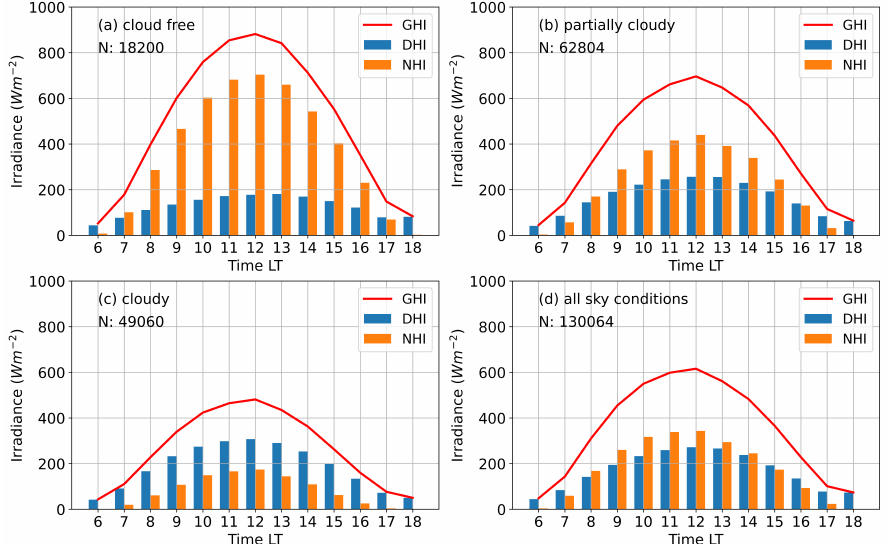
Figure 3. Averages of hourly irradiance values (Wm − 2 ) for global (GHI), diffuse (DHI) and direct (NHI) horizontal surface solar irradiances for the period 1981–2016 under different sky conditions: ( a ) cloud-free sky, ( b ) partially cloudy, ( c ) cloudy, and ( d ) all sky